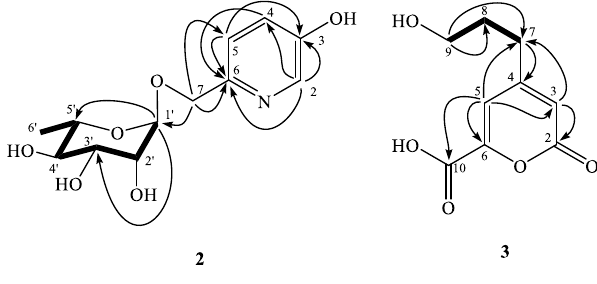
Figure 2. Key COSY ( ▬ ) and HMBC ( → ) correlations of 2 and 3 .